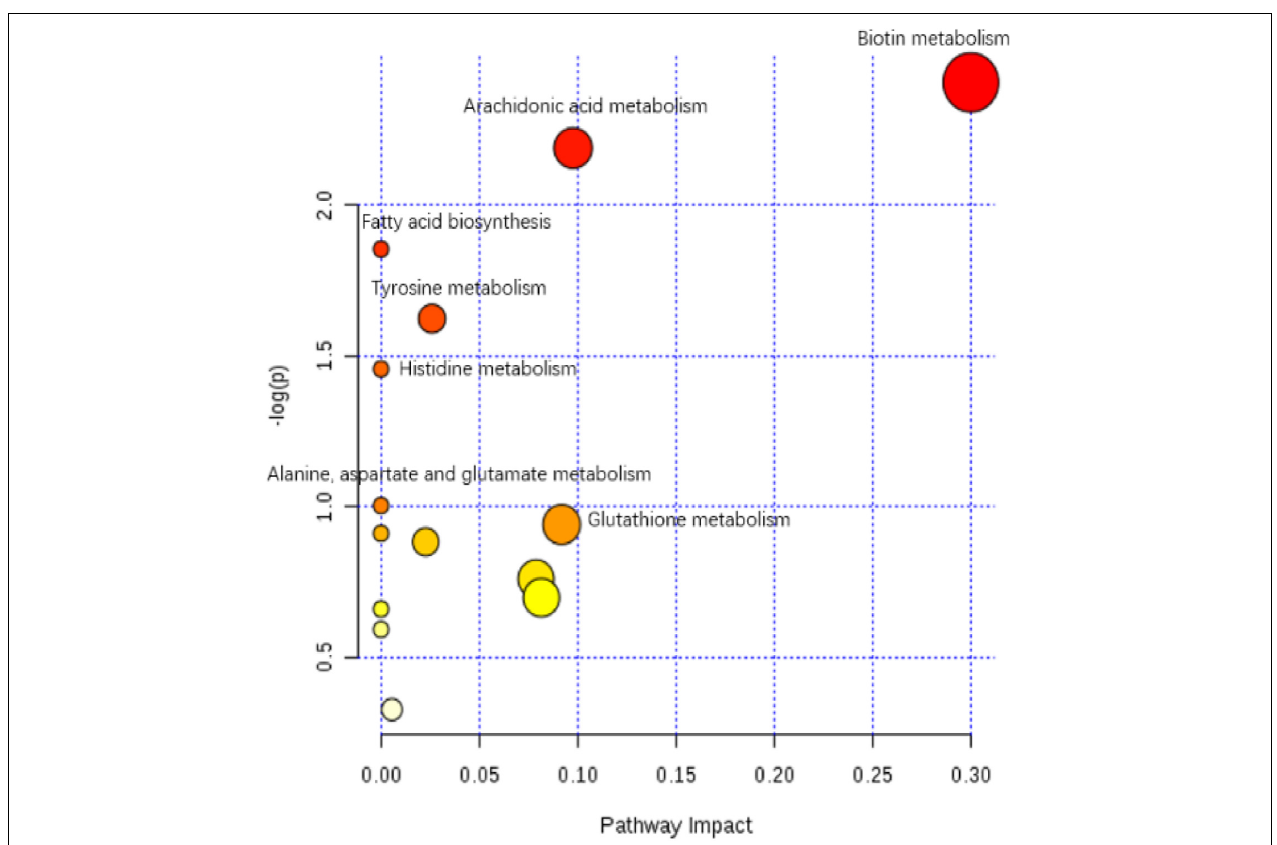
FIGURE 5 | The scatter plot of the metabolic pathway impact and enrichment for all matching significant metabolites in the liver of juvenile American eels of the HIS group in comparison with the control group. The colored points represent different metabolic pathways. The various color levels indicate different levels of significance of metabolic pathways from low (white) to high (red). The different sizes of each point are based on the pathway impact values. Moreover, the most relevant pathways’ names of points are labeled according to the significance and impact value of the metabolic pathway.